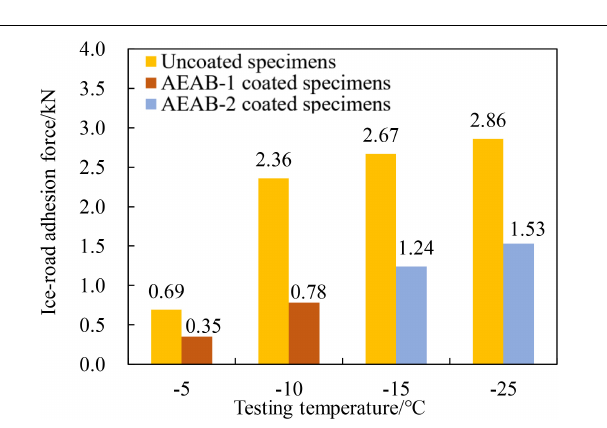
FIGURE 6 | Ice-road adhesion force of AEAB coated and uncoated specimens at different temperature.